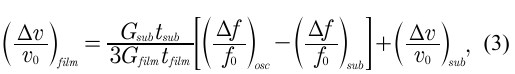
) film are shown in both (a) and (b) for comparison. The insert shows their shear modulus G 2